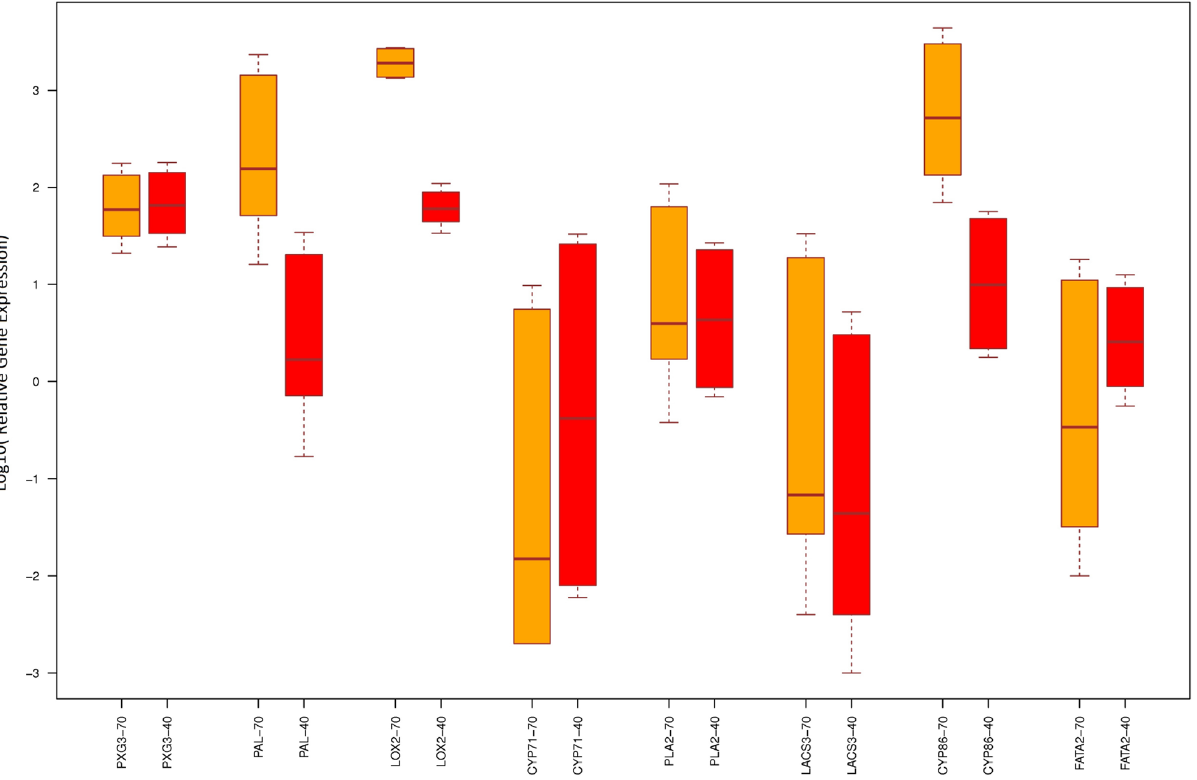
Figure 6. Relative expression analysis of 8 hub genes (4 up-regulated and 4 down-regulated genes) at 70%FC (orange color) and 40% FC (red color) versus FC treatment (field capacity). The relative expression of genes is shown based on Log10. Because the differences in expression between the different genes were so large, logarithms were used to make them easier to display and compare